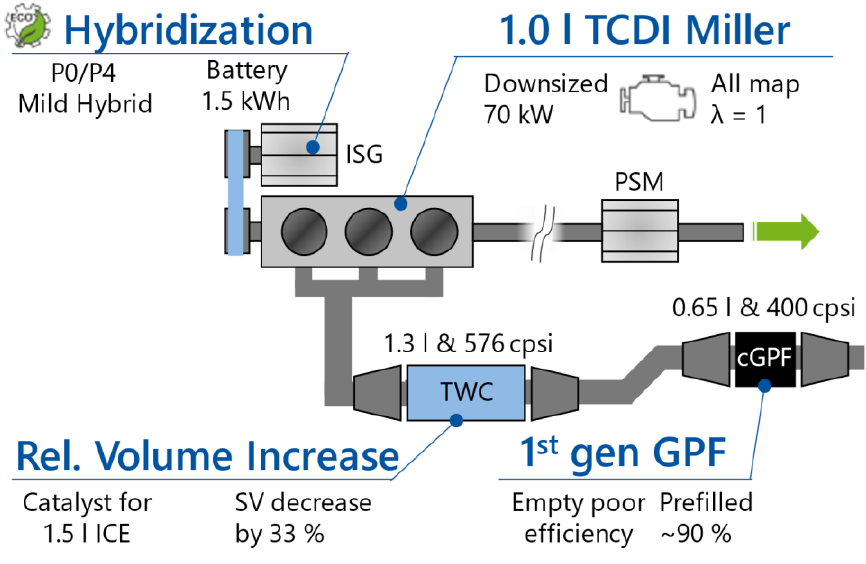
Figure 8. Base technology steps for future 2030+ vehicle concepts.